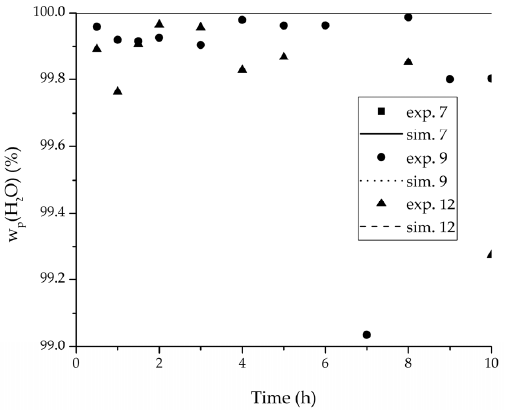
Figure 11. Experimental water mass fractions (feed) over time for three experiments used for the validation of the permeance function for ethyl acetate/water compared with the corresponding simulation result.